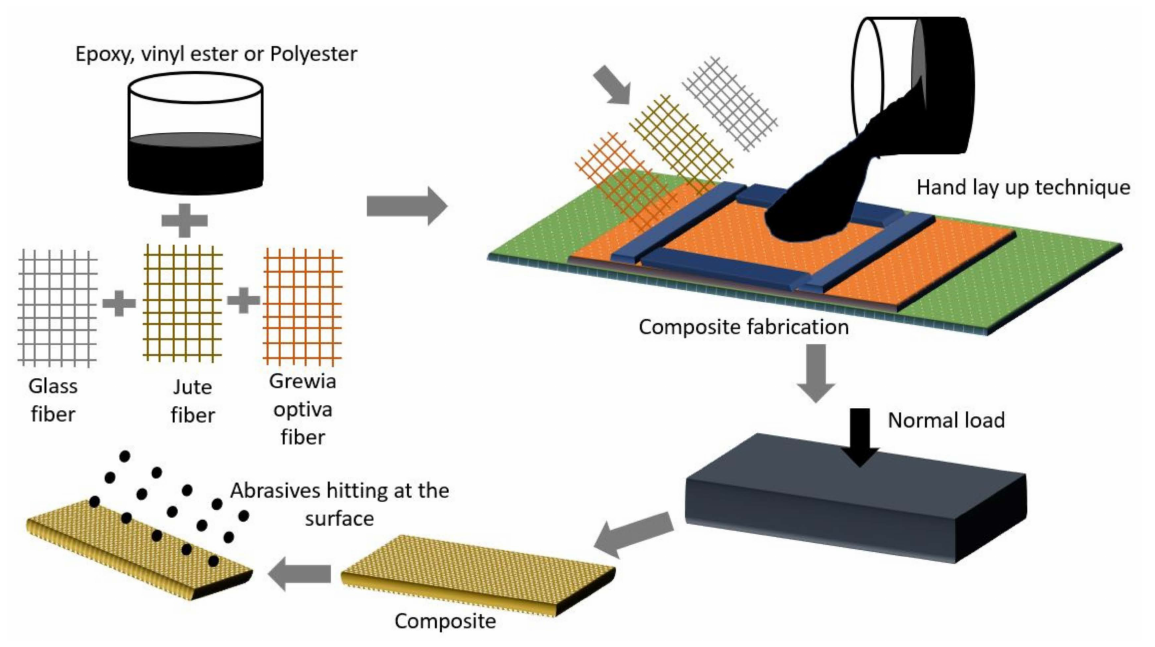
Figure 3. Process of fabrication of composite.